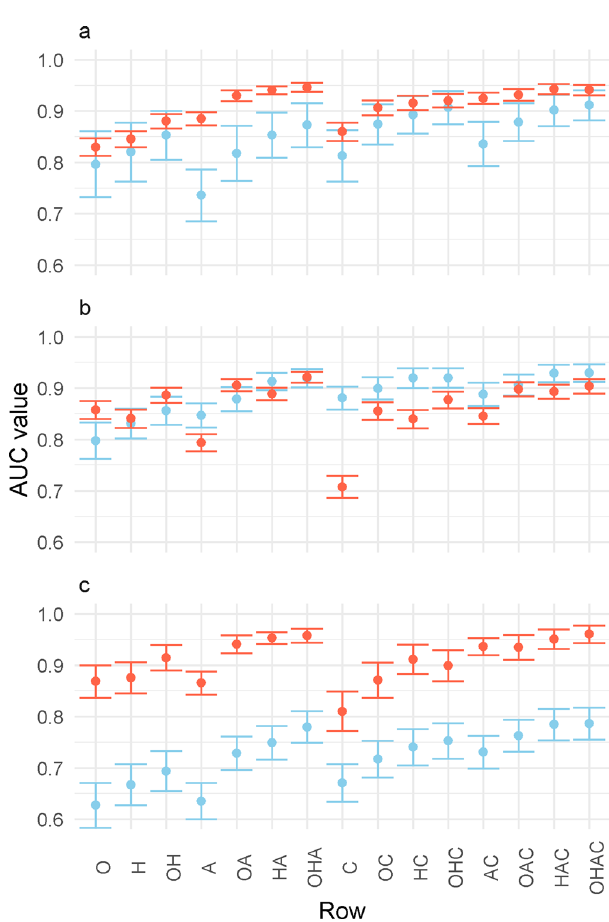
Fig. 2 Comparison of training and validating AUC values for human, NHP and municipalities with both. AUC values for the classi fi cation of a municipality as having ( A ), human YF report ( B ), NHP YF report and ( C ) human and NHP YF report. The x -axis numbers refer to the models found in Table 1. Red refers to the training AUC value and blue the validation AUC value. Error bars represent the 95% con fi dence intervals of the prediction, calculated from the 100 out-of-sample validation AUC values for each model formulation. N = 100 out-of-sample calculations of the AUC for 15 independent models.